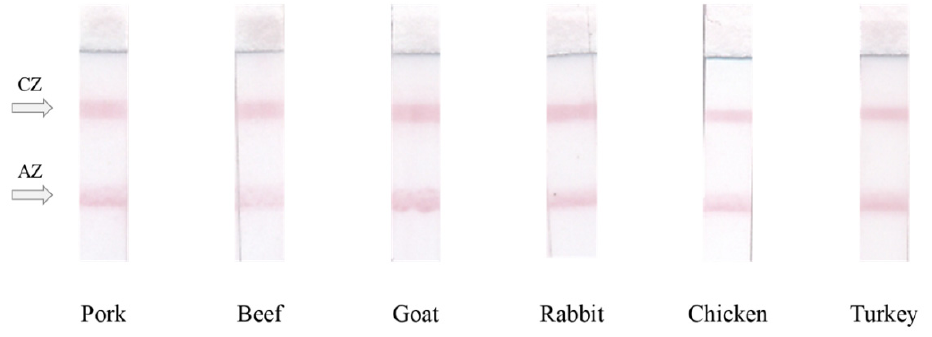
Figure 6. The appearance of the test strips when testing meat extracts from different species. AZ—analytical zone, CZ—control zone.